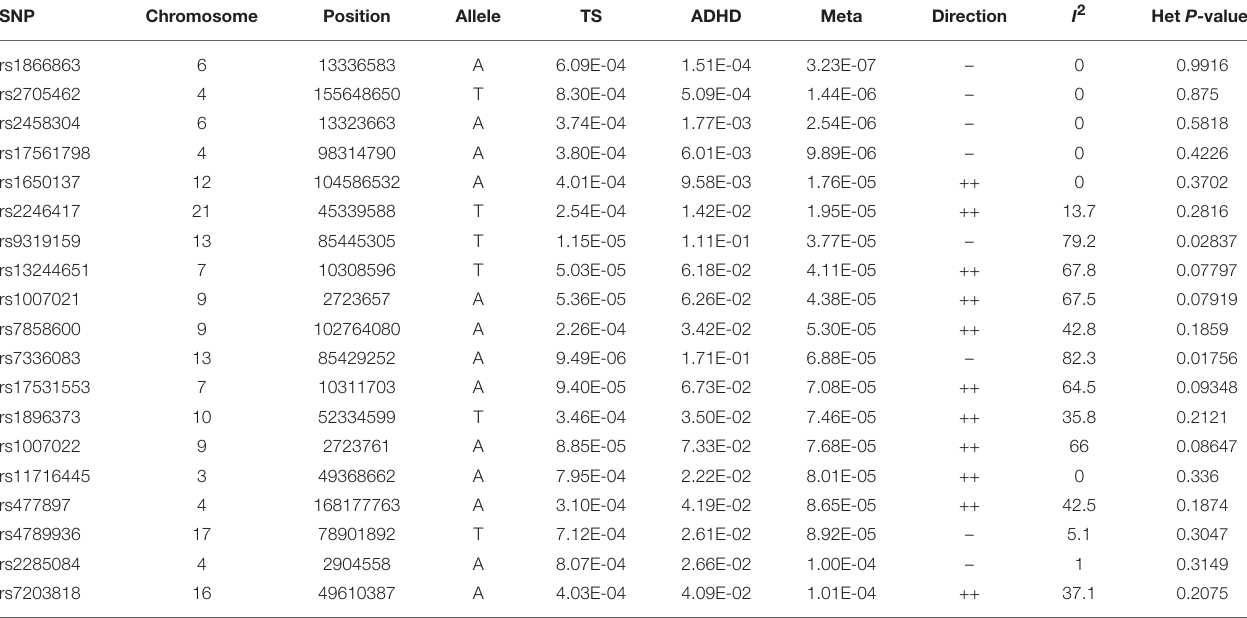
TABLE 1 | Significant results of the